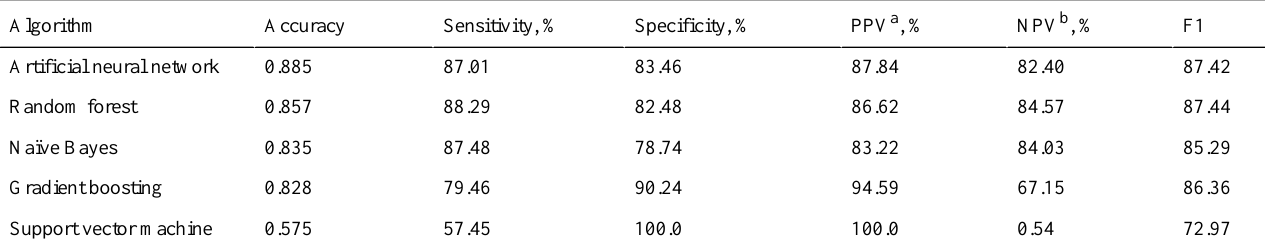
Table 2. Performance of the prediction